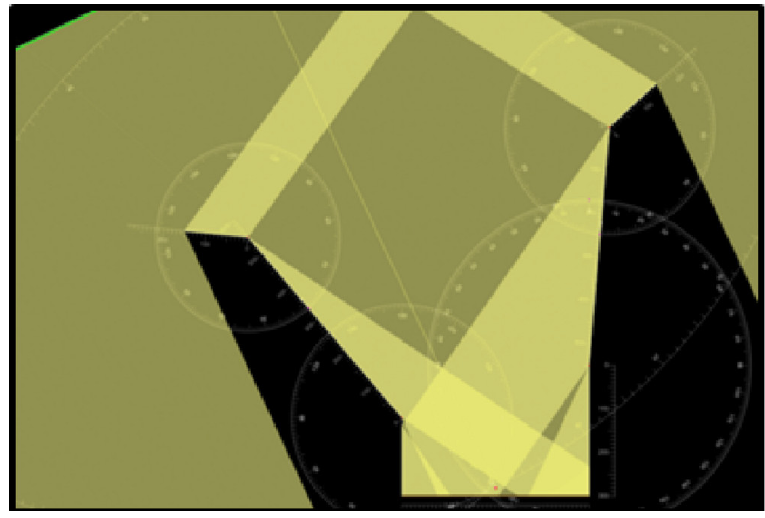
Figure 2. Ray diagram showing the light rays directed to the box where the vessel is kept.